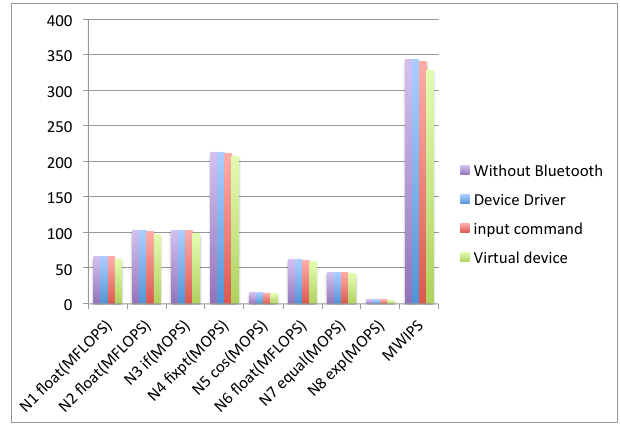
Fig. 9. Java Whet Stone